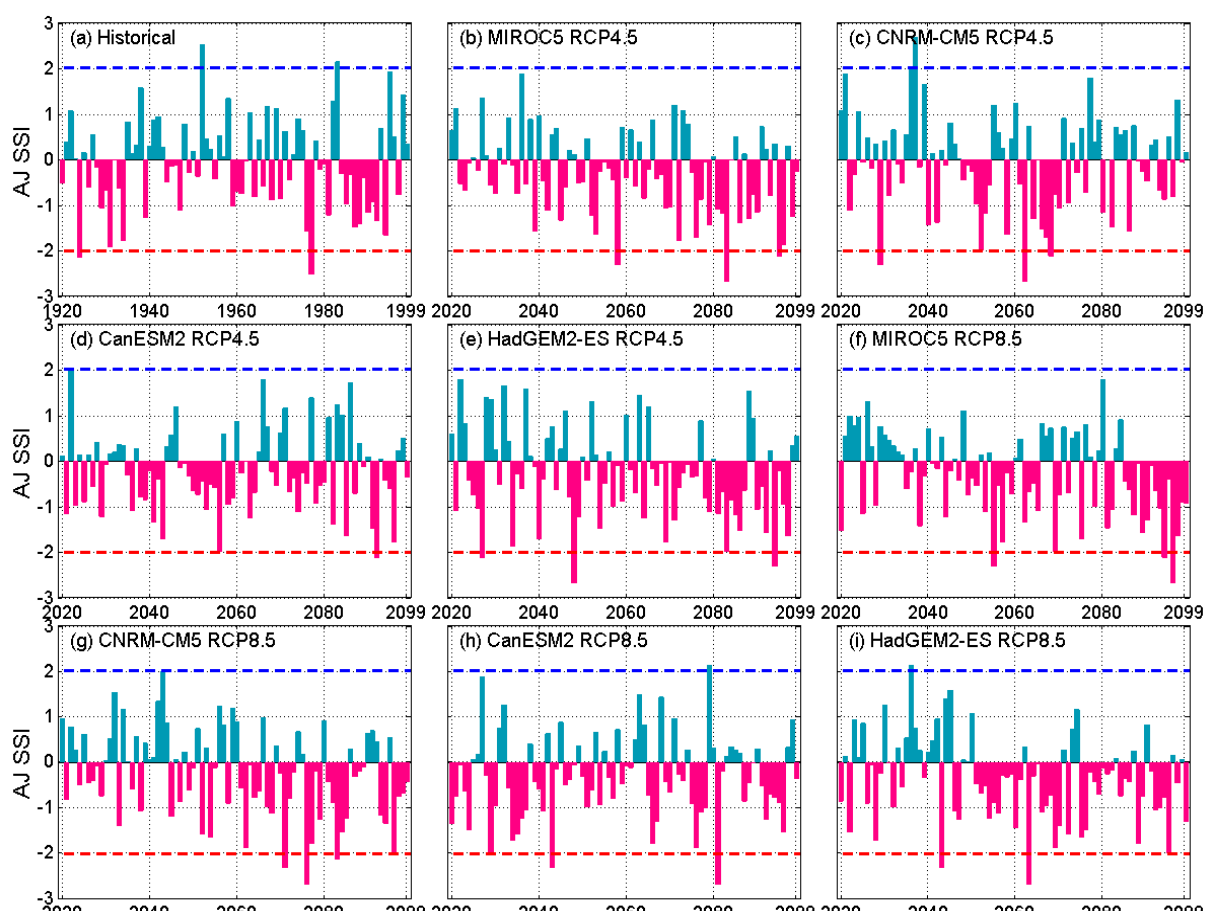
Figure 6. Historical and projected April–July Standardized Streamflow Index (SSI) for SAC4. Values that are above the blue dash line represent extremely wet conditions while values below the red dash line indicate extremely dry conditions.